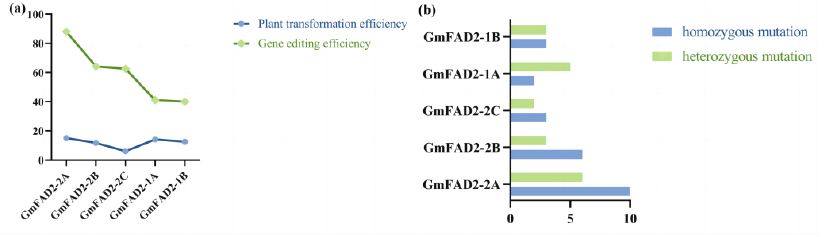
Figure 6. Editing efficiency and mutation type of different editing vectors: ( a ) comparison of editing efficiency and conversion efficiency of different editing vectors; ( b ) edited plant mutation types.